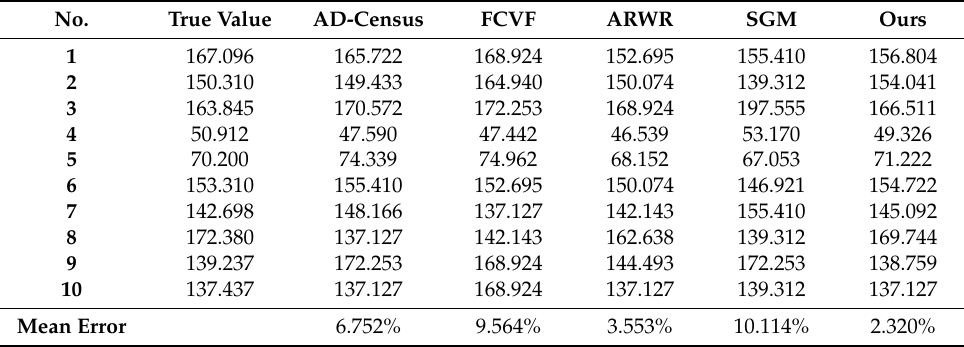
Figure 12. Sampling points of our measurement experiments. ( A ) The underwater image of a barrier; ( B ) The underwater image of a warning notice; ( C ) The underwater image of a flowerpot. Table 6. Data of distance measurement experiments for underwater targets (unit: